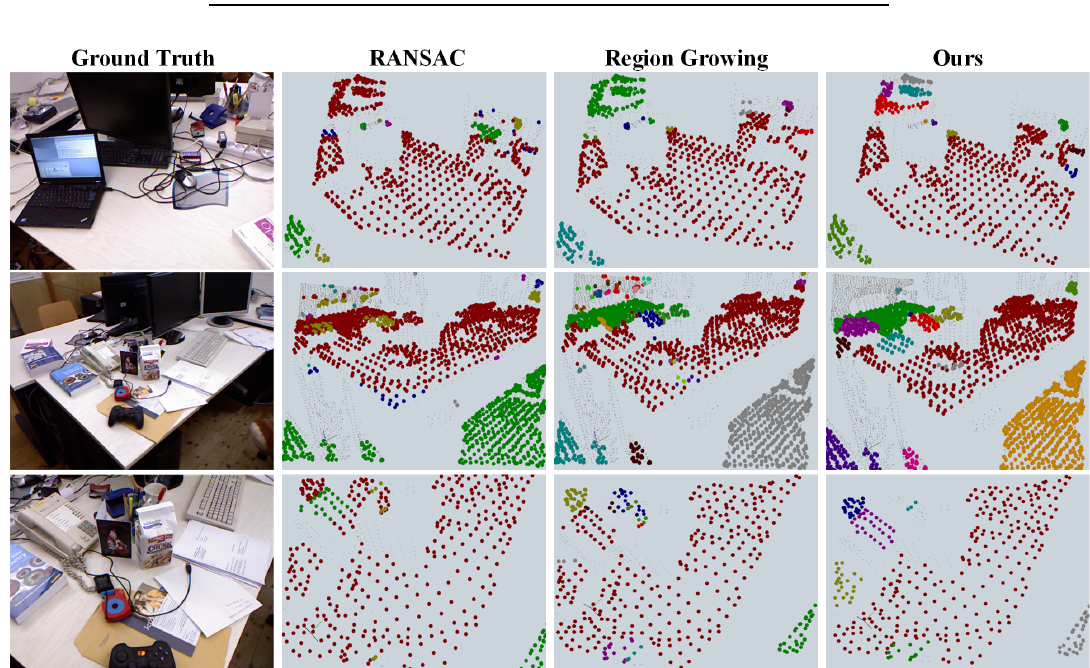
Figure 6. Intermediate results yielded by baseline methods and our methods on segmenting multiple horizontal planes in the 3D sequence freburg1_desk of TUM RGB-D dataset. Please note that our